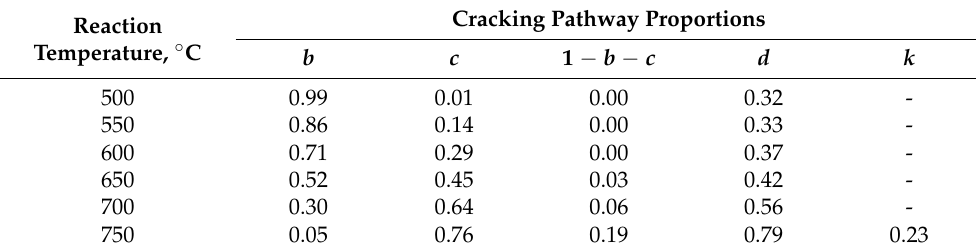
Table 3. Cracking pathway proportions of pentene under various temperatures. Reaction conditions: total pressure, 130 kPa; partial pressure, 60 kPa; WHSV, 83 h − 1 .